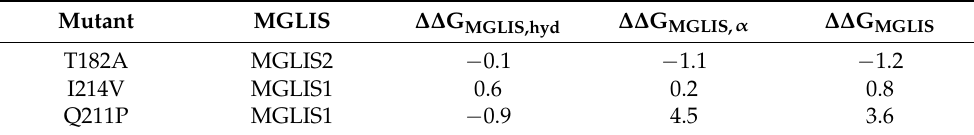
Table 2. Estimated change in stability (in k T) of the corresponding MGLIS for mutations T182A, I214V, and Q211P, located in the two predicted primary contacts of the prion protein. Mutation T182A increases the stability of MGLIS2, while mutations I214V and Q211P reduce the stability of MGLIS1. Mutant MGLIS ∆∆ G MGLIS,hyd ∆∆ G MGLIS, α ∆∆ G MGLIS T182A MGLIS2 − 0.1 − 1.1 − 1.2 I214V MGLIS1 0.6 0.2 0.8 Q211P MGLIS1 − 0.9 4.5